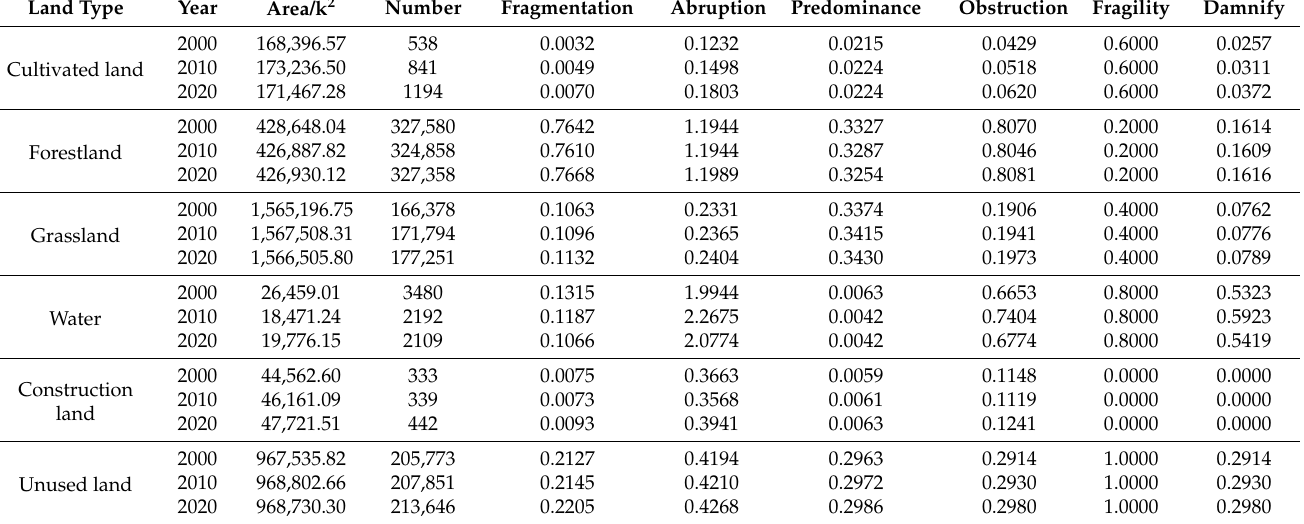
Table A6. Landscape pattern index of Ahal State from 2000 to